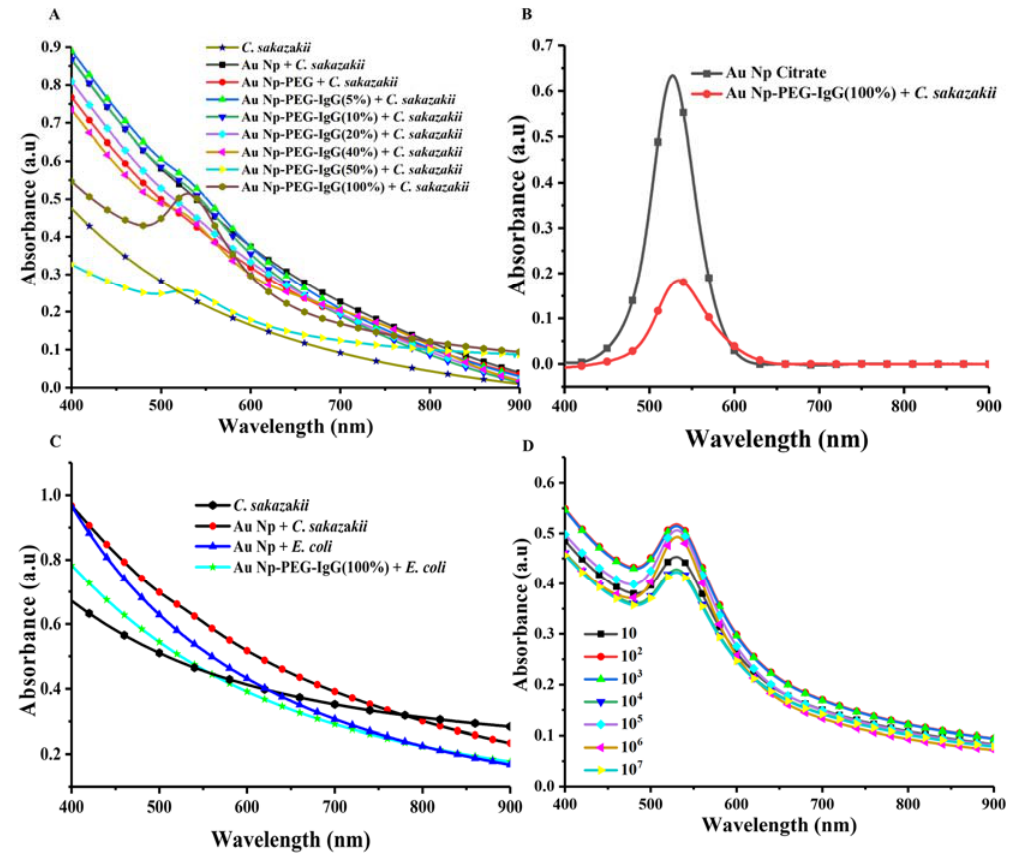
Figure 4. UV-Vis extinction spectra of C. sakazakii incubated with nanoparticles. ( A ) C. sakazakii at a concentration of 10 3 CFU/mL incubated with targeted Au nanoparticles, functionalized with different percentages of biotin end-groups (HS-PEG-biotin 0–100%) and functionalized with biotinylated anti- C. sakazakii IgG via streptavidin. The samples were incubated for 2 h at room temperature and excess free particles thereafter were removed by filtration; ( B ) C. sakazakii at a concentration of 10 3 CFU/mL incubated with targeted Au nanoparticles stabilized with 100% HS-PEG-biotin and functionalized with biotinylated anti- C. sakazakii IgG via streptavidin. The sample was incubated for 2 h at room temperature and excess free particles thereafter were removed by filtration. The background of a sample containing only C. sakazakii was subtracted to reveal the extinction peak of the targeted Au nanoparticles. Also, the extinction peak of a pure dispersion of functionalized Au nanoparticles at known initial concentration with baseline correction; ( C ) negative controls of C. sakazakii and E. coli incubated with PEGylated Au NPs followed by removal of the free particles by filtration as well as C. sakazakii without Au NPs. Additionally, E. coli incubated with Au NPs 100% functionalized with anti- C. sakazakii , following the same procedure and conditions as in ( A ). ( D ) C. sakazakii at different concentrations 10 1 to 10 7 CFU/mL incubated with Au nanoparticles stabilized with 100% HS-PEG-biotin 100% and functionalized with biotinylated anti- C. sakazakii IgG via streptavidin. Please note that the sample containing 10 7 CFU/mL was diluted 25 times for the absorption measurement due to high background